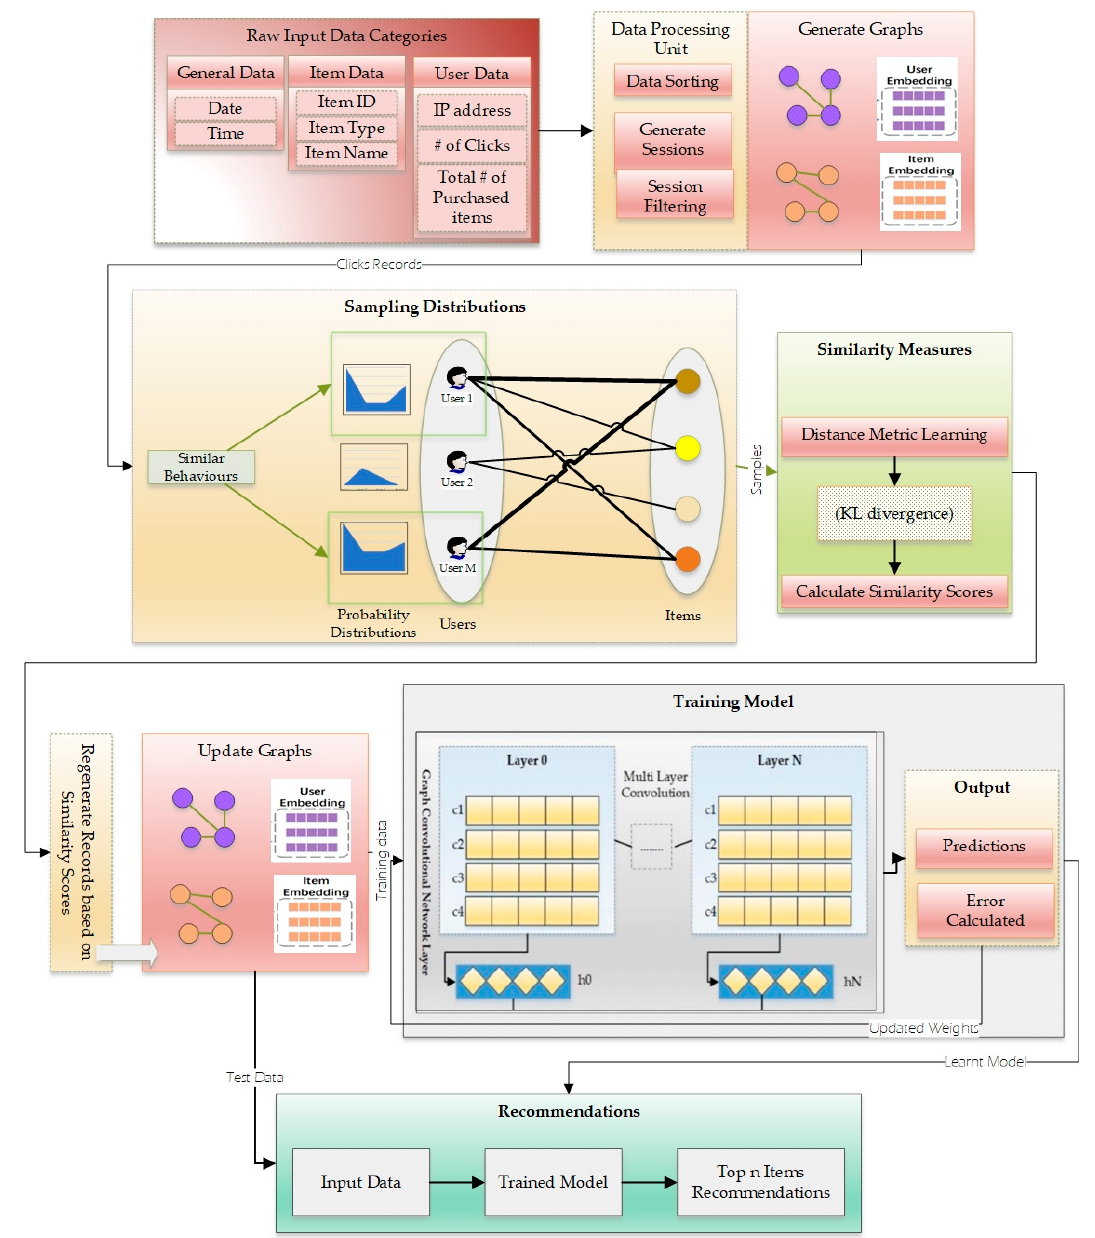
Figure 6. Detailed view of the proposed framework.